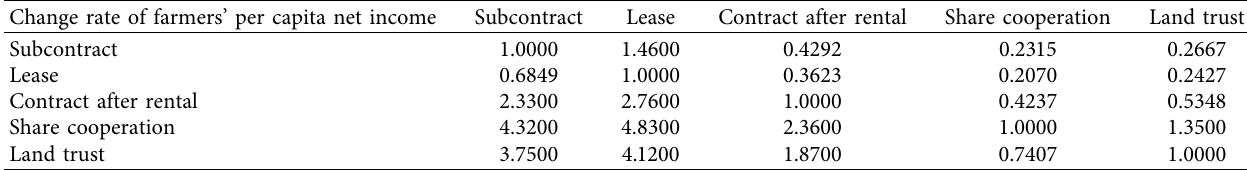
Table 4: Indicator layer and the alternative selection comparison value list of the rural land circulation mode performance evaluation.